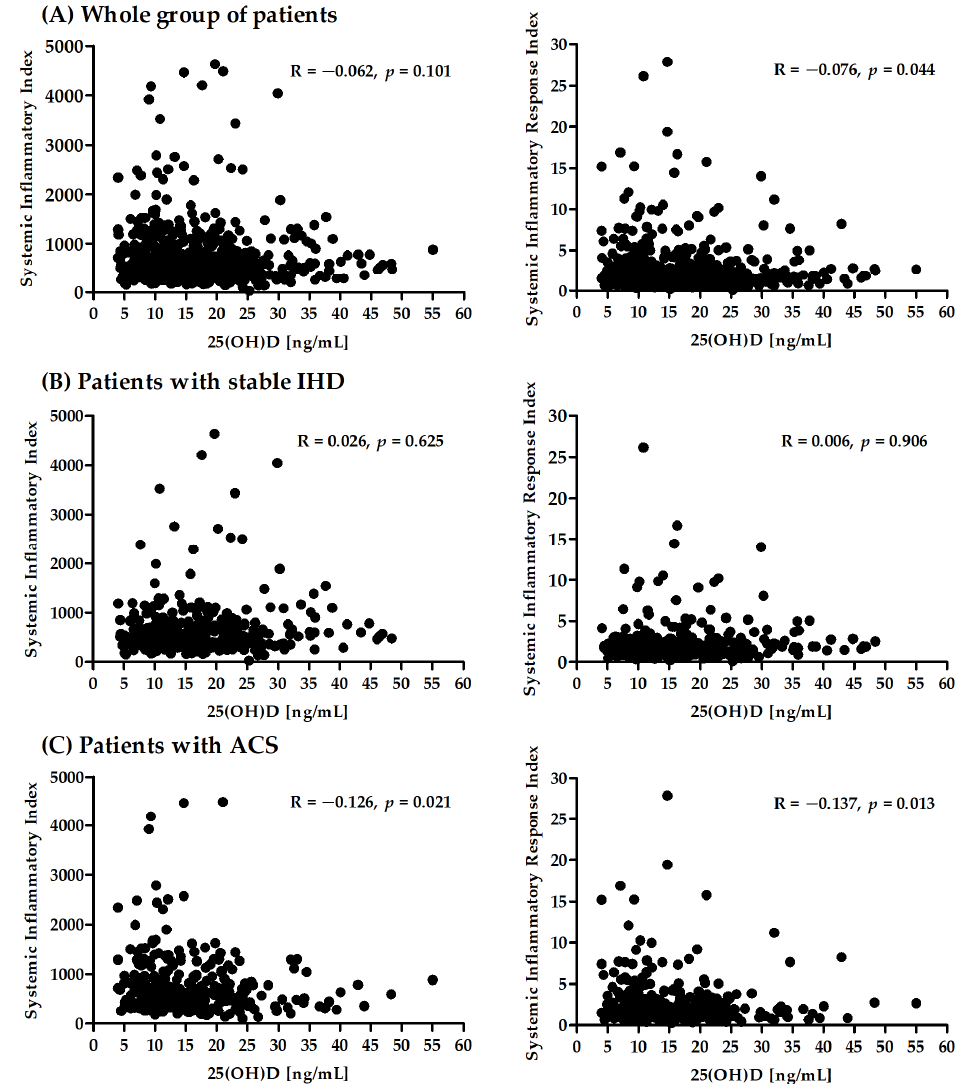
Figure 1. Correlation between SII, SIRI, and 25(OH)D concentration in the whole group ( A ) and separately for patients with stable IHD ( B ) and ACS ( C ).